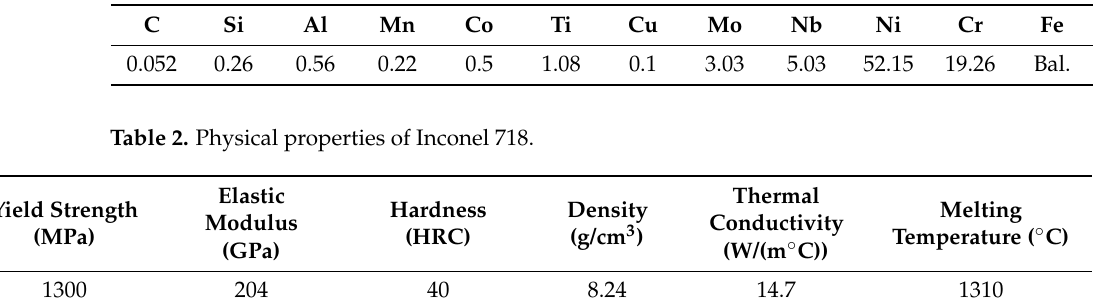
Table 1. Nominal composition of Inconel 718 (wt.%).